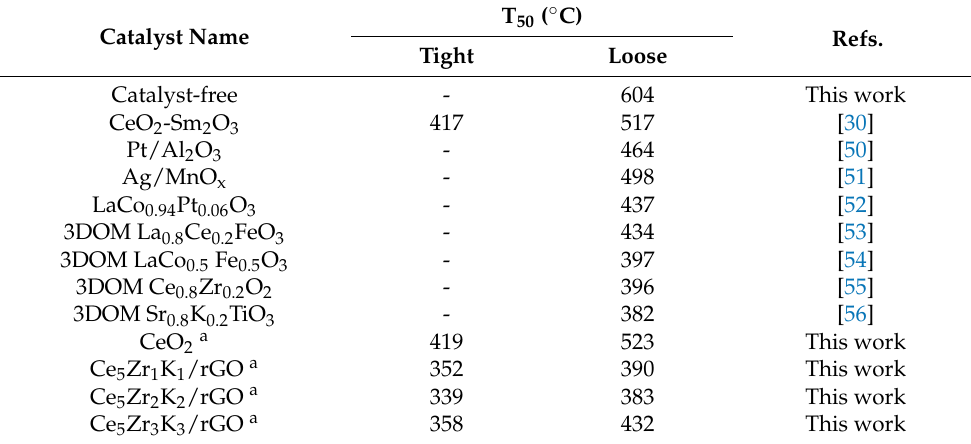
Table 5. T 50 of various catalysts for soot oxidation under tight contact and loose contact conditions.